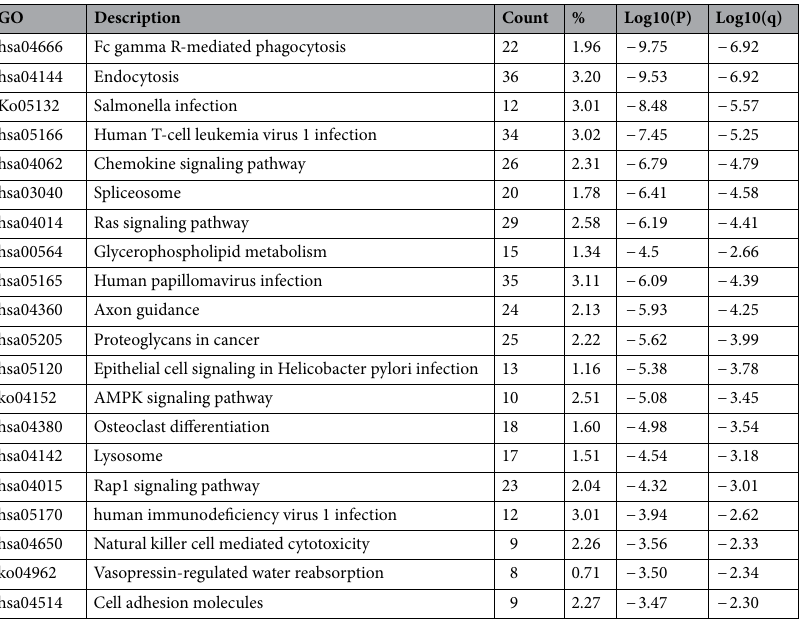
Table 5. Top 20 clusters with meta-analysis of KEGG enrichment pathway of SCAMP2/4/5 and their co-expressed